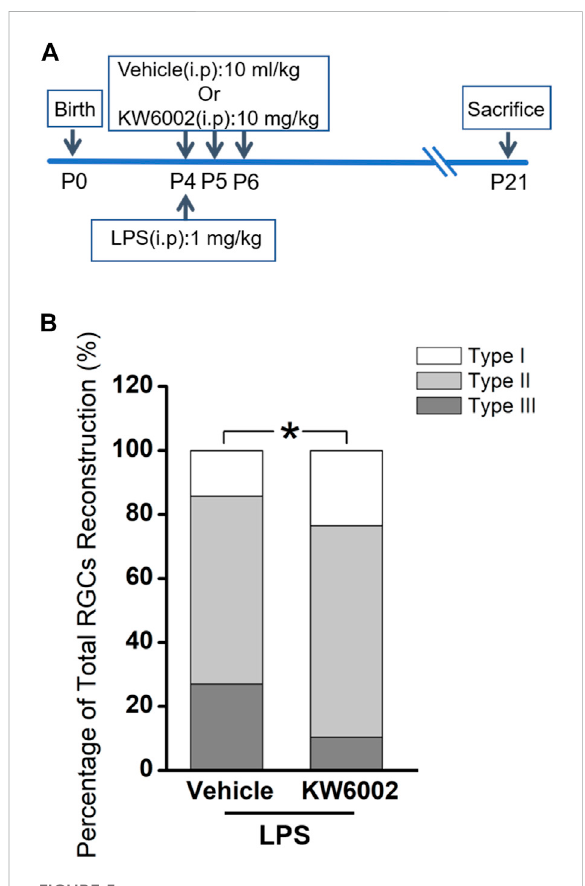
FIGURE 5 KW6002 changed the proportion of RGC morphological types after neonatal in fl ammation. (A) Timeline of KW6002 (or vehicle) administration with an intraperitoneal injection of LPS in transgenic Thy-1 YFPH mice. (B) The proportion of different morphological types of RGCs from the control and KW6002- treatedmiceafterneonatalLPSexposure.* p < 0.05.63RGCsfrom 14 retinas (7 vehicle-treated mice) and 68 RGCs from 12 retinas (6 KW6002-treated mice) in the control and KW6002-treated group after neonatal LPS exposure, respectively. On average, 4.5 and 5.67 RGCs per eye were analyzed in each